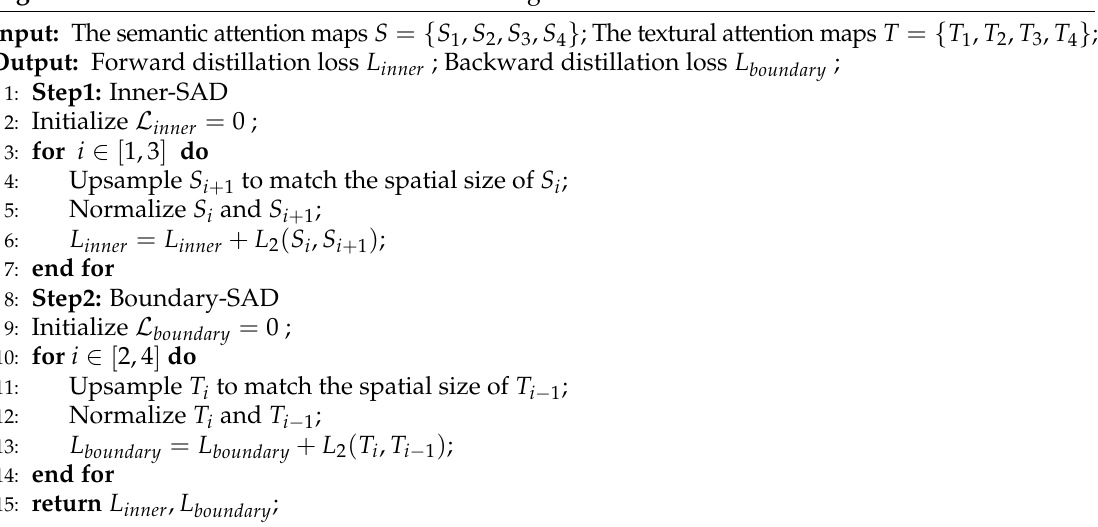
Algorithm 2 Bidirectional self-attention knowledge